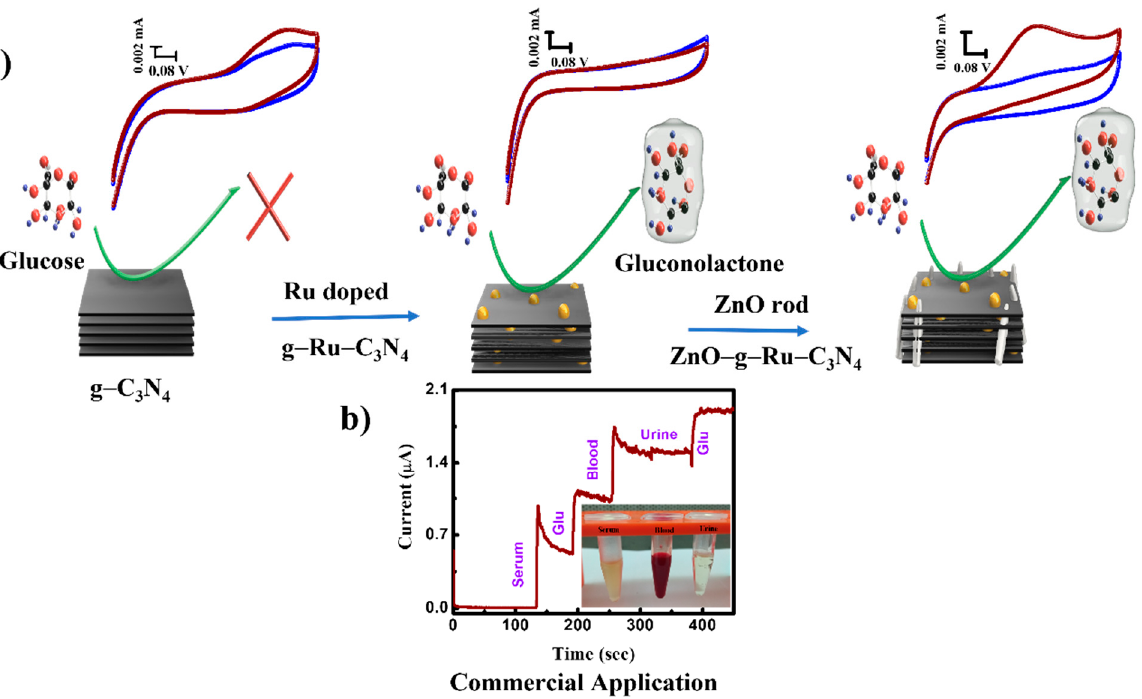
Figure 3. CV behavior of g–C 3 N 4 ( a ), g–Ru–C 3 N 4 ( b ) and ZnO–g–Ru–C 3 N 4 ( c ) modified electrode and used for the glucose sensing. Measured in PBS in the absences (curve a) and presences (curve b) of 1 mM glucose at a scan rate 50 mV s − 1 .